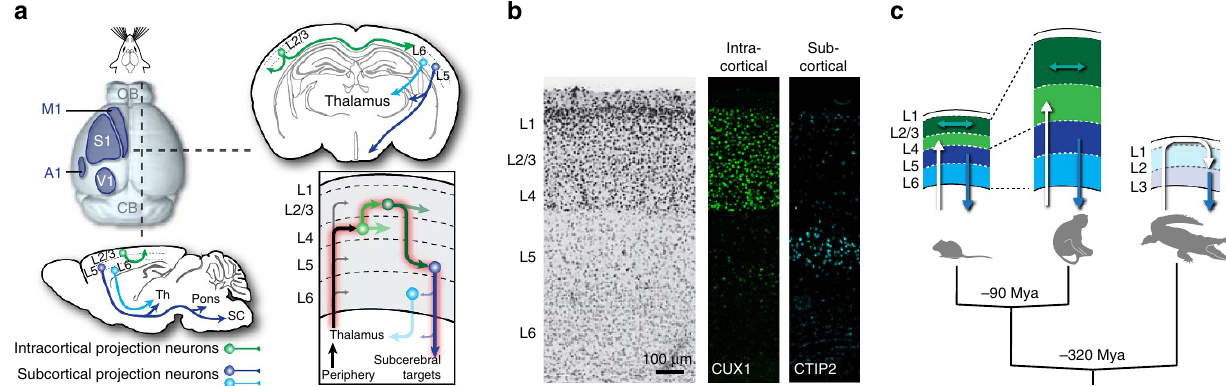
Figure 1 | Areal and laminar organization of the neocortex. ( a ) Schematic representation of the distinct primary cortical areas in the mouse, and cell-type specific connectivity of glutamatergic cortical neurons. A1: primary auditory cortex, M1 primary motor cortex, S1: primary somatosensory cortex, V1: primary visual cortex. ( b ) Laminar organization of the neocortex (S1). CUX1 specifically labels intracortical projection neurons while CTIP2 labels corticospinal neurons in layer (L) 5. ( c ) Laminar organization of the neocortex in mammals and reptiles. Mya: millions of year